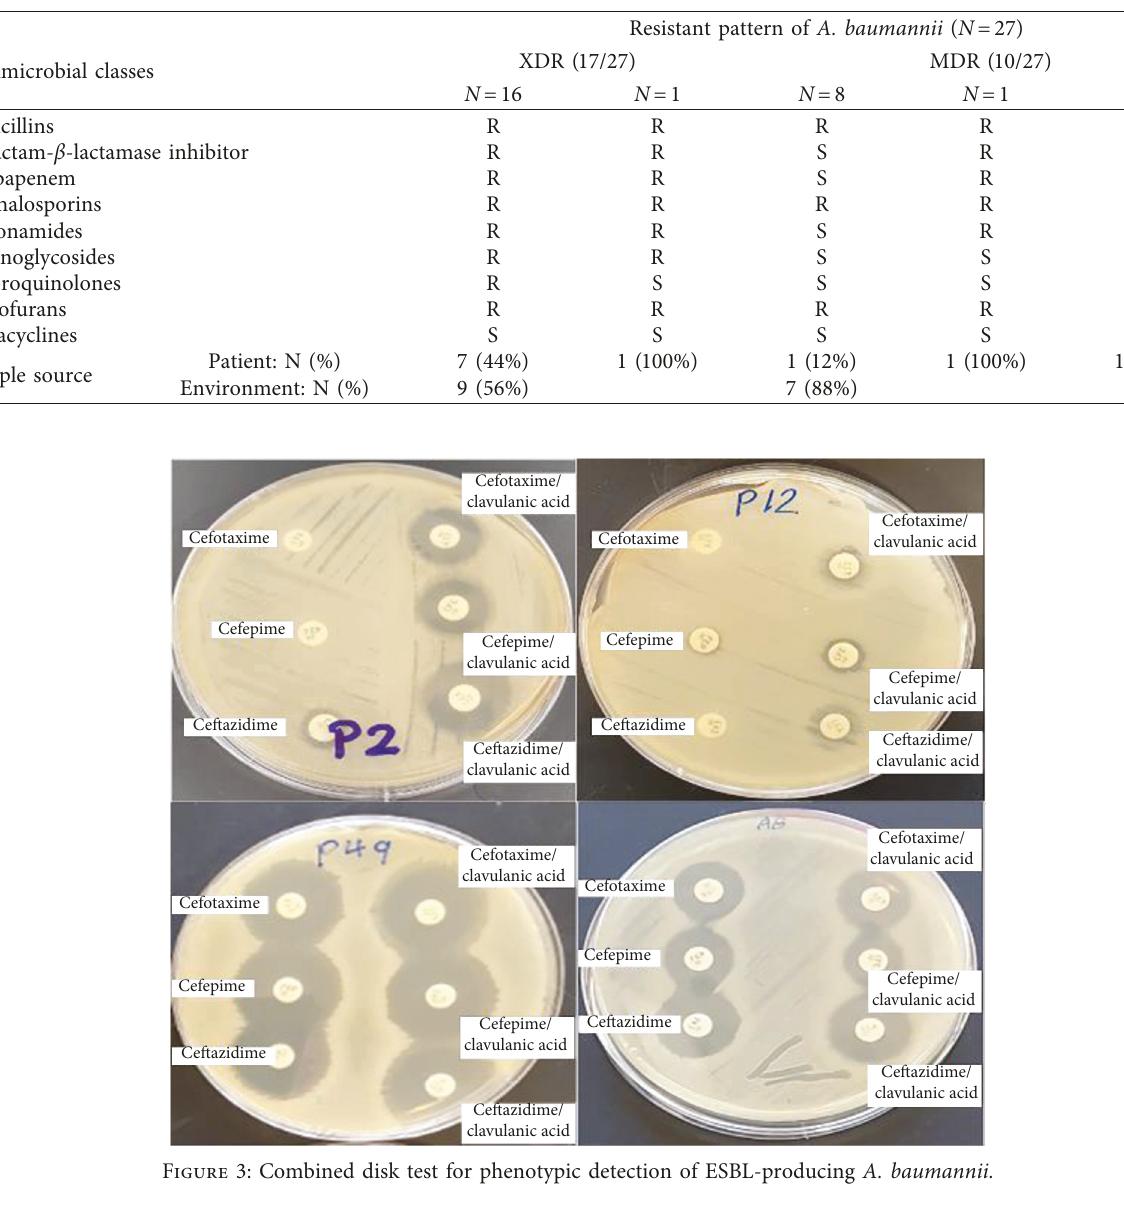
Table 5: Resistant pattern XDR and MDR of A. baumannii .